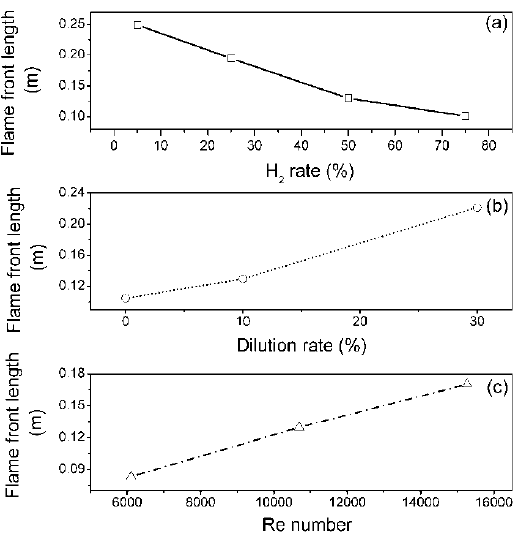
Figure 9. Length of wrinkled flame front under different flame conditions: ( a ) nitrogen dilution volumetric proportion of 10%, Re = 10,690, different hydrogen proportion in fuel; ( b ) hydrogen volumetric rate of 50%, Re = 10,690, different nitrogen dilution; ( c ) nitrogen dilution volumetric proportion of 10%, hydrogen volumetric ratio of 50%, different Reynolds number.